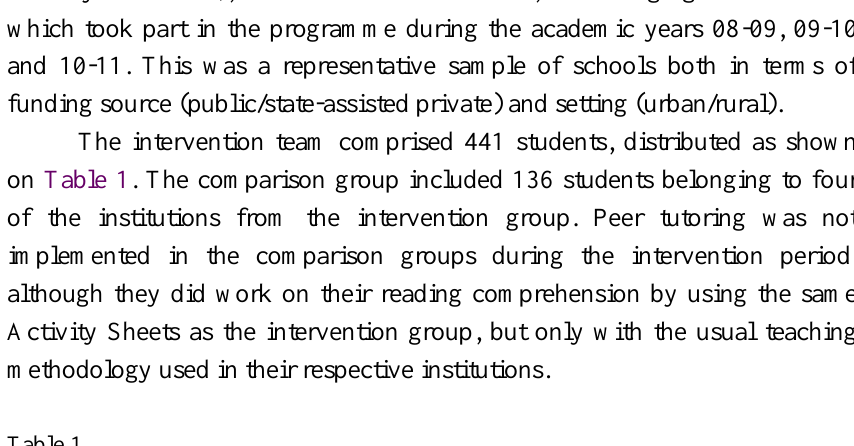
Distribution of the intervention